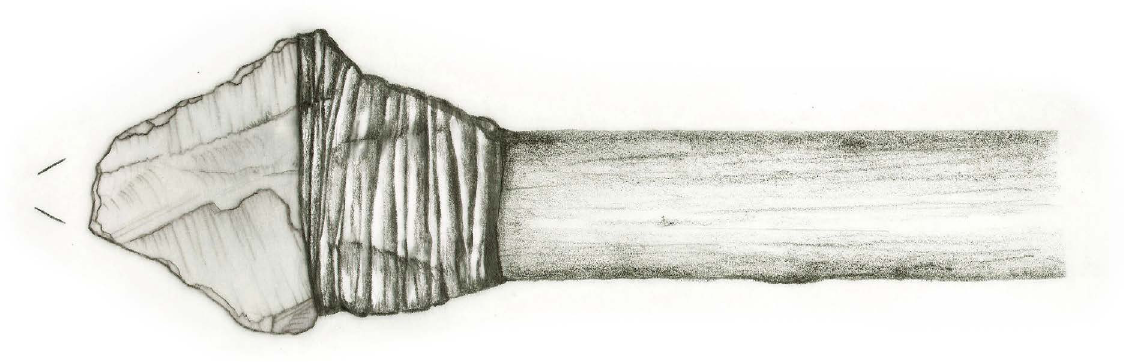
Figure 11. Ideal reconstruction of the tool hafted as a spear, taken from the microwear traces and tool morphology. No other evidence of a handle is has been found in the archaeological record of the